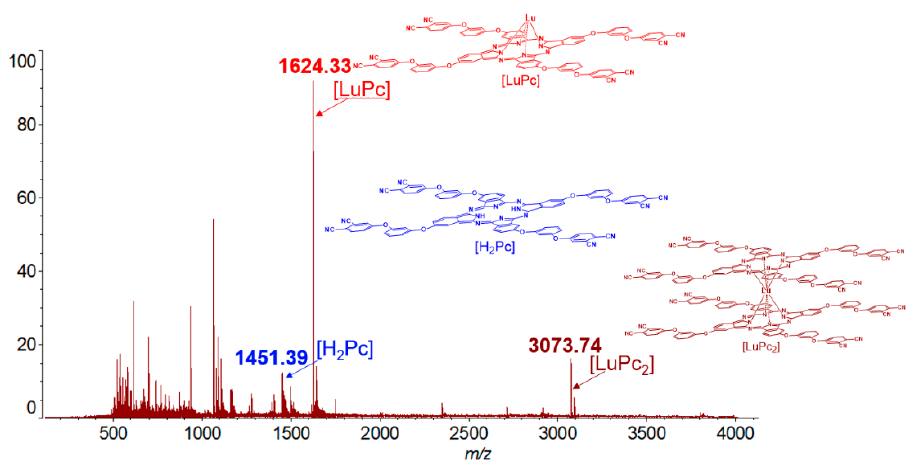
Figure 1. HR MALDI-TOF mass spectrum of reaction mixture after template fusion reaction with lutetium(III) acetate (CHCA as matrix).